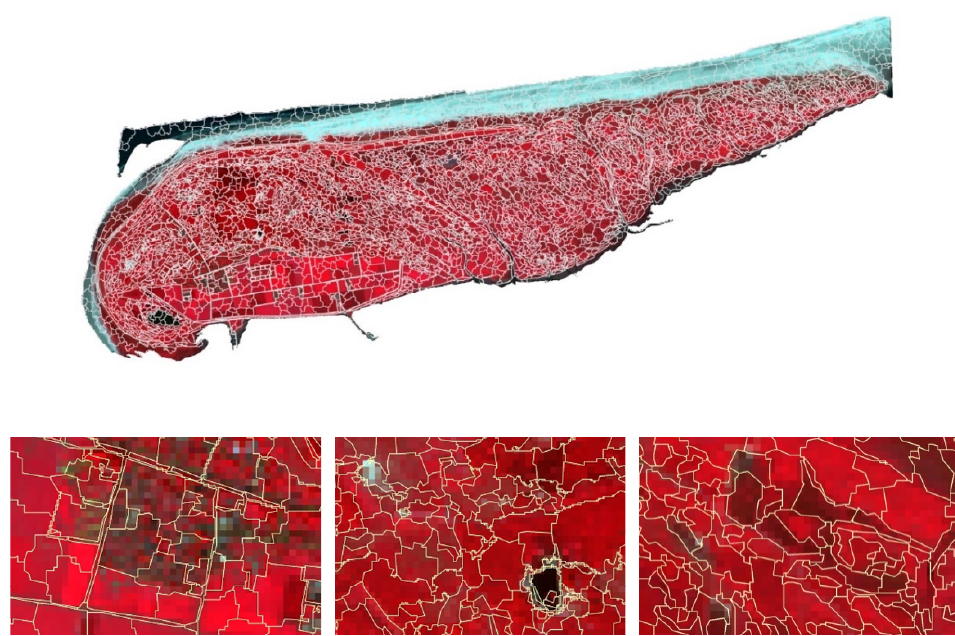
Figure 3. Segmentation result of RapidEye image with h s = 5 and h r = 7, on a false colour composite of Sentinel-2 (B08, B04, B03).